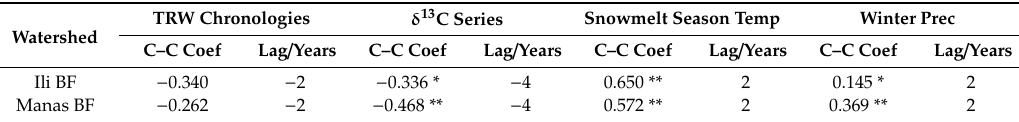
Table 8. Cross-correlation between baseflow (BF) and tree-ring variables (TRW chronologies and δ 13 C series), climatic factors (temperature and precipitation) of the Ili and Manas, and lags between the baseflow and tree-ring variables or climatic